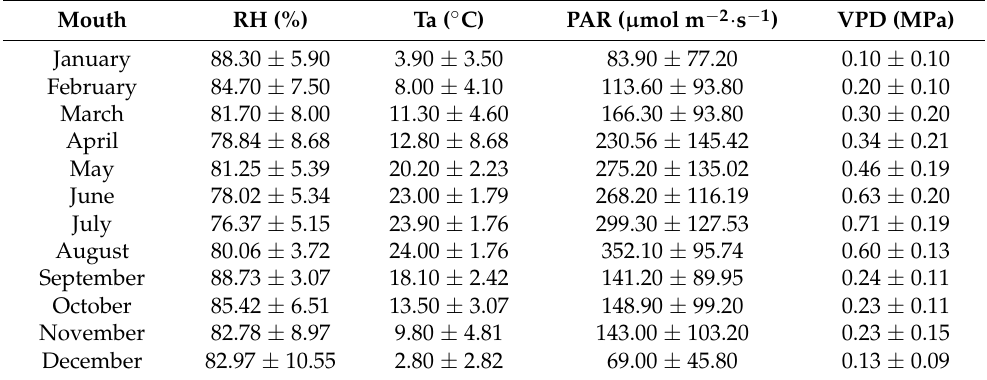
Table 2. Descriptive statistics for four environmental factors. From top to bottom are 1 to 12 months, the data structure is mean + standard error, all values are kept to two decimal places.